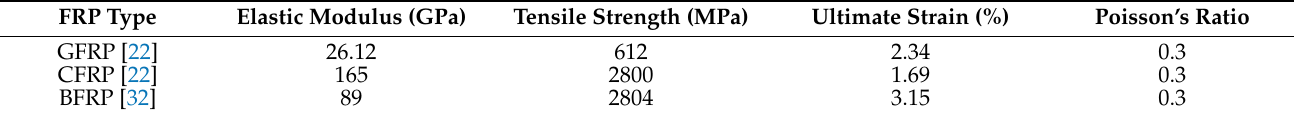
Table 3. Mechanical properties of different FRPs.